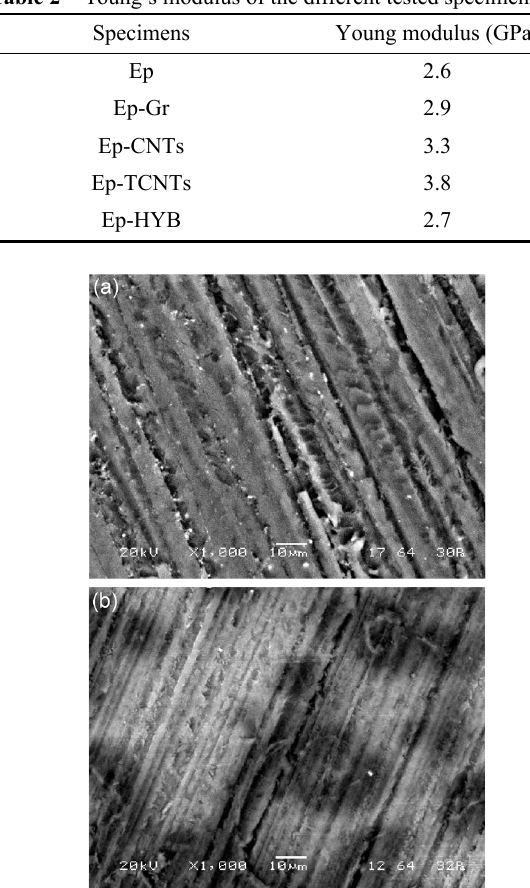
Fig. 9 SEM images showing the dispersion of (a) TCNT and (b) CNT in an epoxy matrix.